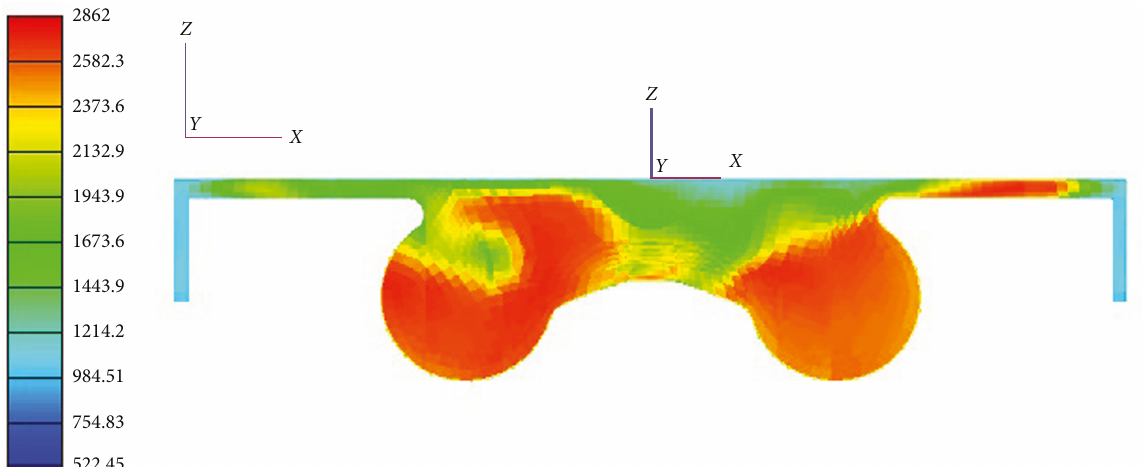
Figure 4: The temperature fi eld under 730 ° CA of the original